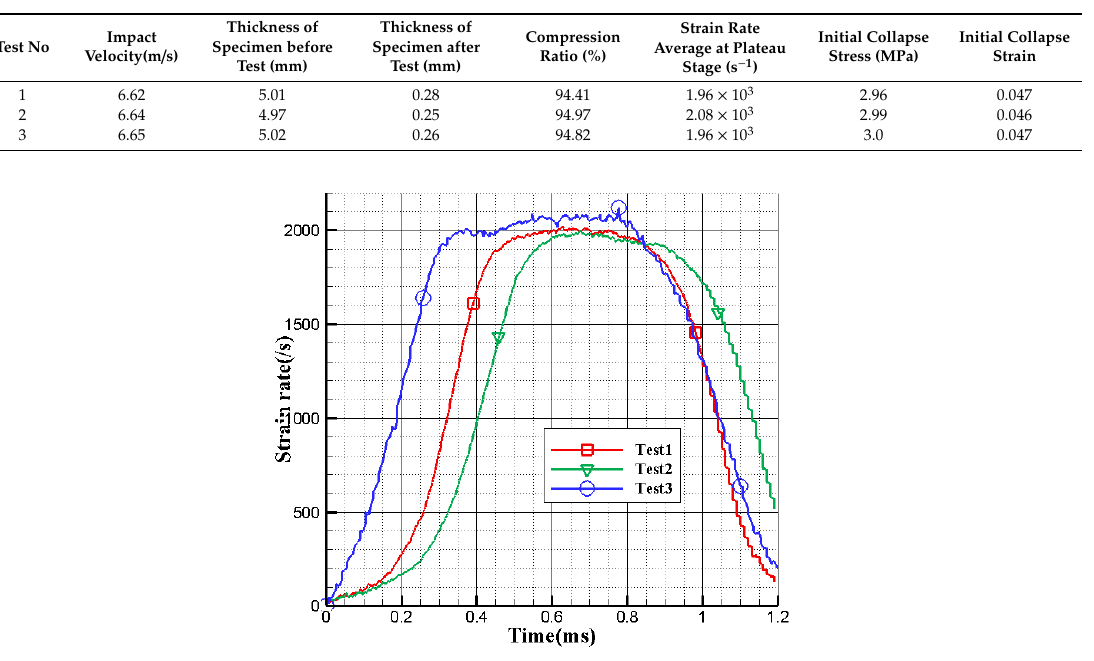
Table 4. The results of the dynamic compression tests under the strain rate 2 × 10 3 s − 1 .